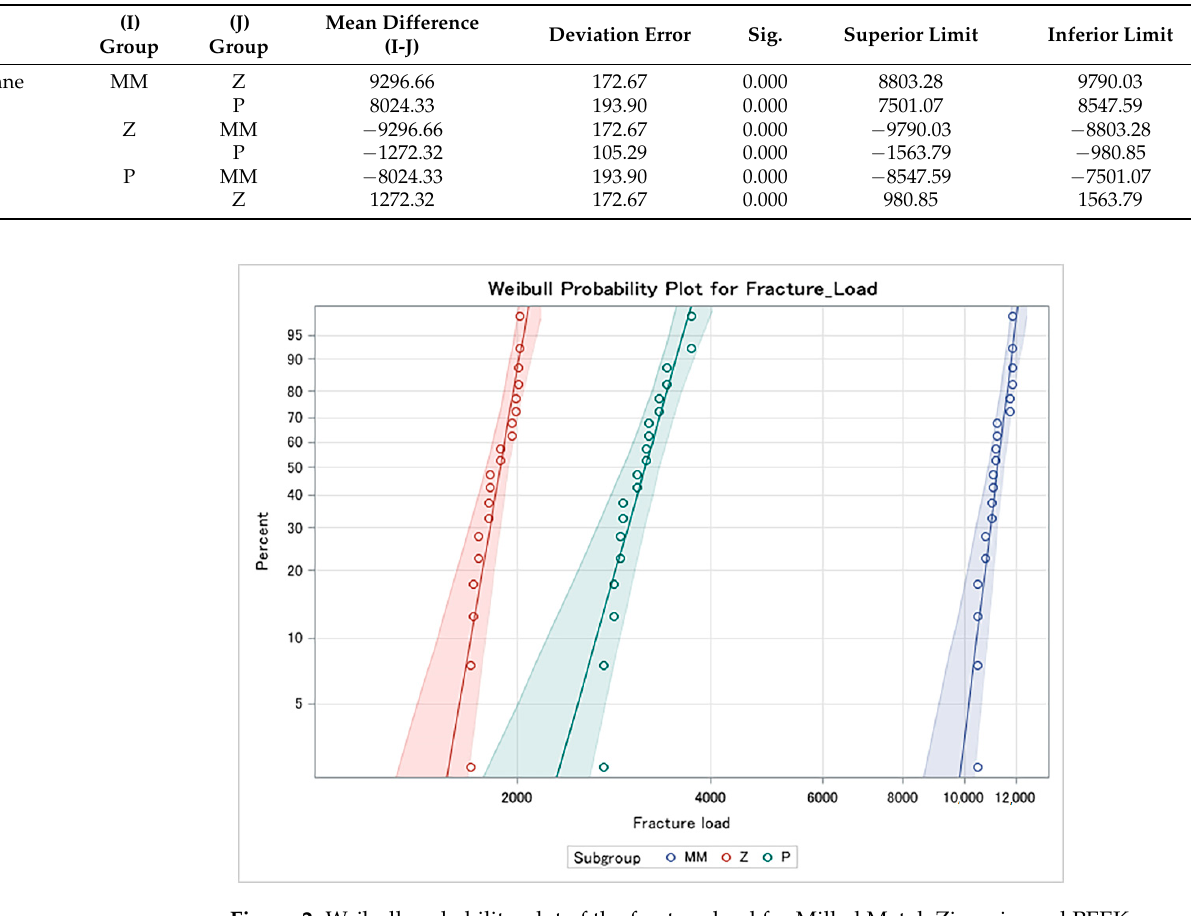
Figure 2. Weibull probability plot of the fracture load for Milled Metal, Zirconia, and PEEK groups.